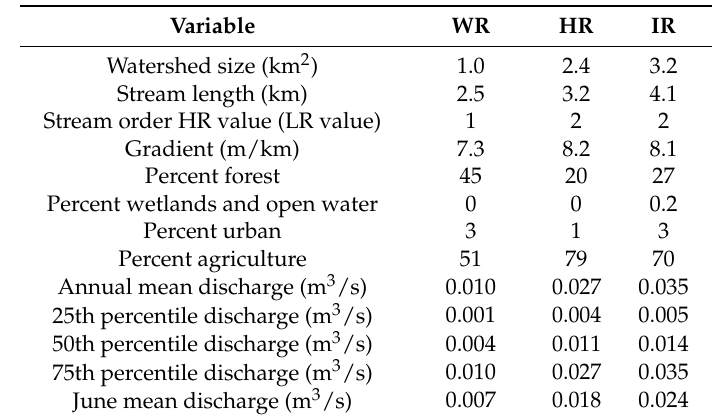
Table 1. Watershed and predicted hydrologic characteristics of three agricultural headwater streams of Alum Creek, OH, USA. All watershed and predicted hydrologic variables except percent agriculture were obtained for each tributary from StreamStats 4.0 [28]. Percent agriculture calculated as the difference between 100 and the sum of percent forest, wetlands/open water and urban areas reported by StreamStats 4.0 [28]. This calculation method for percent agriculture resulted in values from IR that were similar to those obtained from the Great Lakes Long-Term Hydrologic Impact Assessment Model